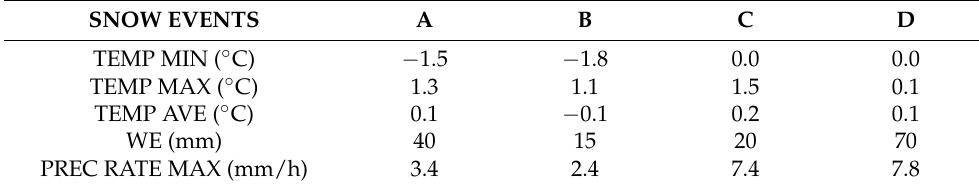
Table 7. Meteorological conditions of the snowfall events.